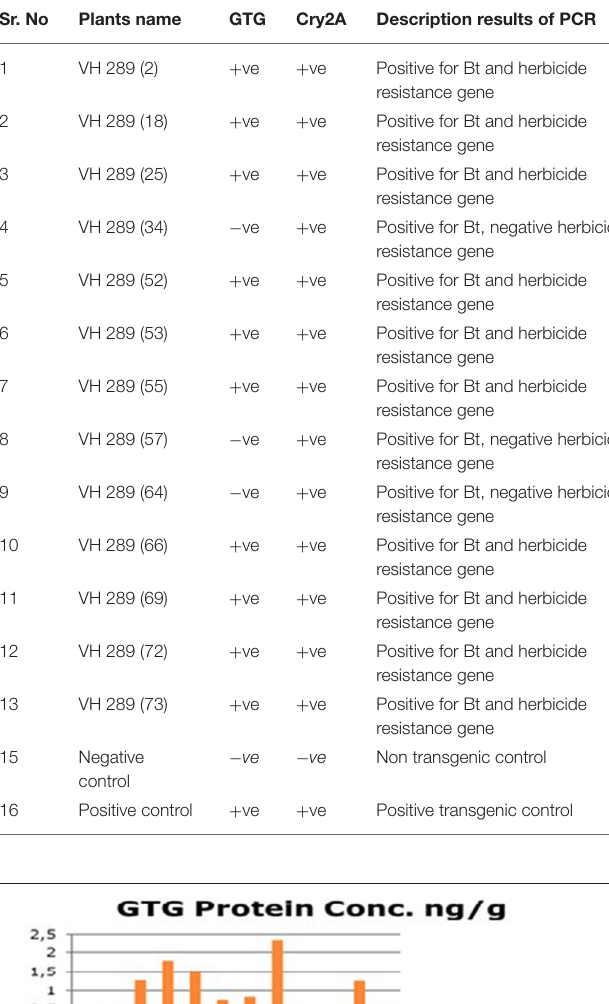
TABLE 4 | Summary of PCR amplification of putative transgenic cotton plants. Sr. No